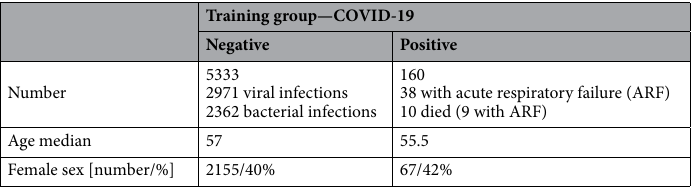
Table 1. Demographic features of included patient